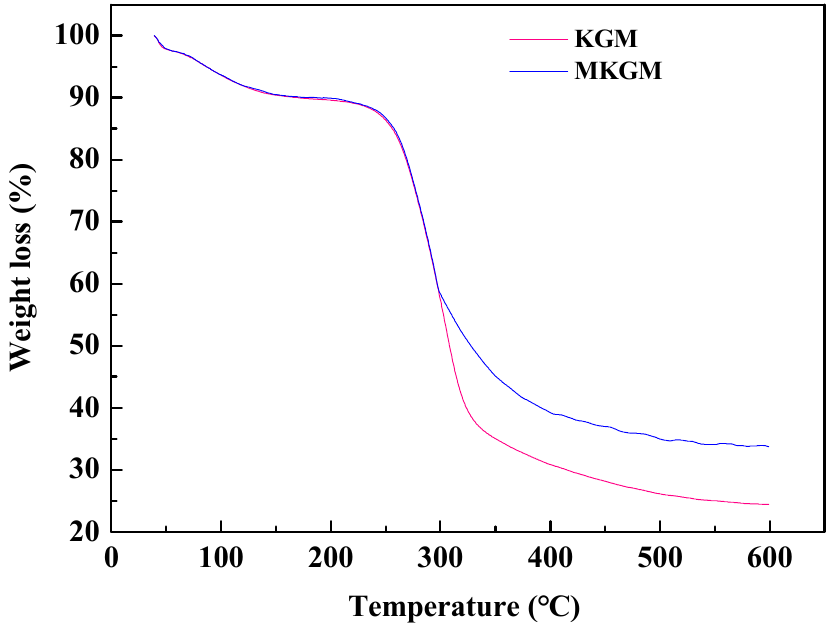
Figure 4. TGA curves of KGM(A) and MKGM(B).